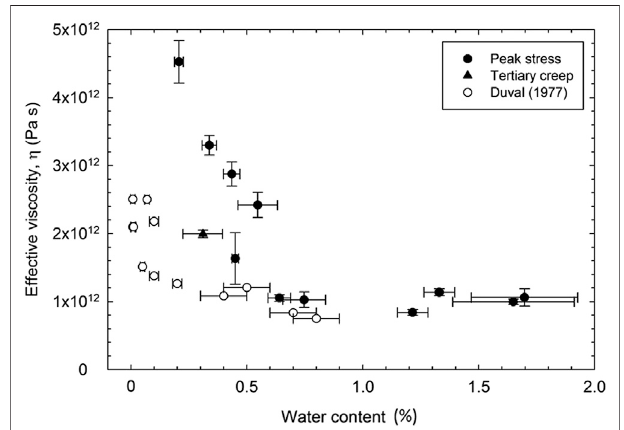
FIGURE 6 | Effective ice viscosity as a function of water content, as measured in the 11 experiments to peak stresses and one tertiary-creep experiment of this study, compared with the tertiary-creep results of Duval (1977). Duval ’ s rotary experiments were conducted at a constant shear stress of 0.29 MPa.